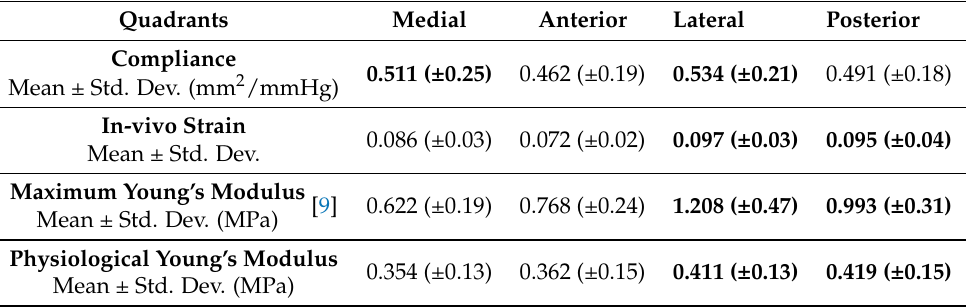
Table 4. Comparison of in-vivo local compliance, strain, and ex-vivo Young’s modulus. Between the in-vivo dataset and the ex-vivo dataset, 22 common patients were selected. The values in bold are selected pairs with the highest